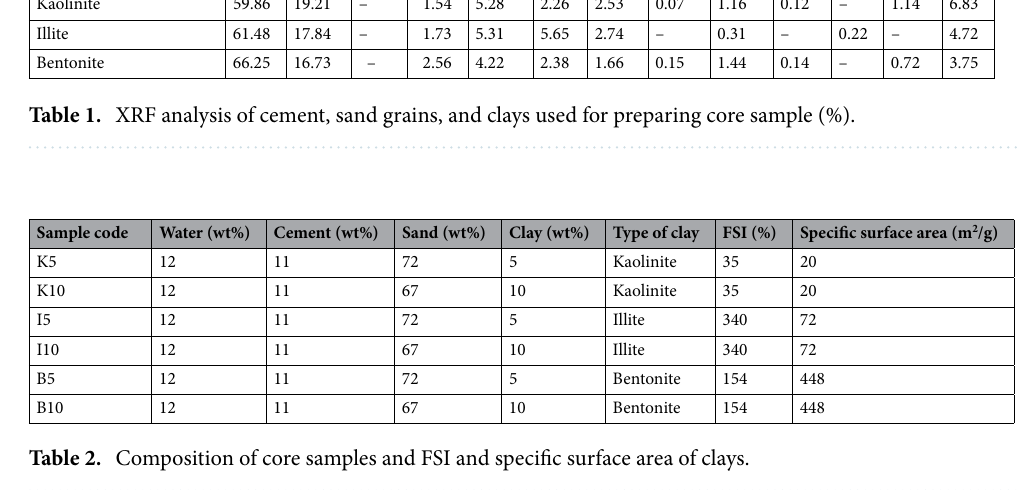
Table 2. Composition of core samples and FSI and specific surface area of clays.